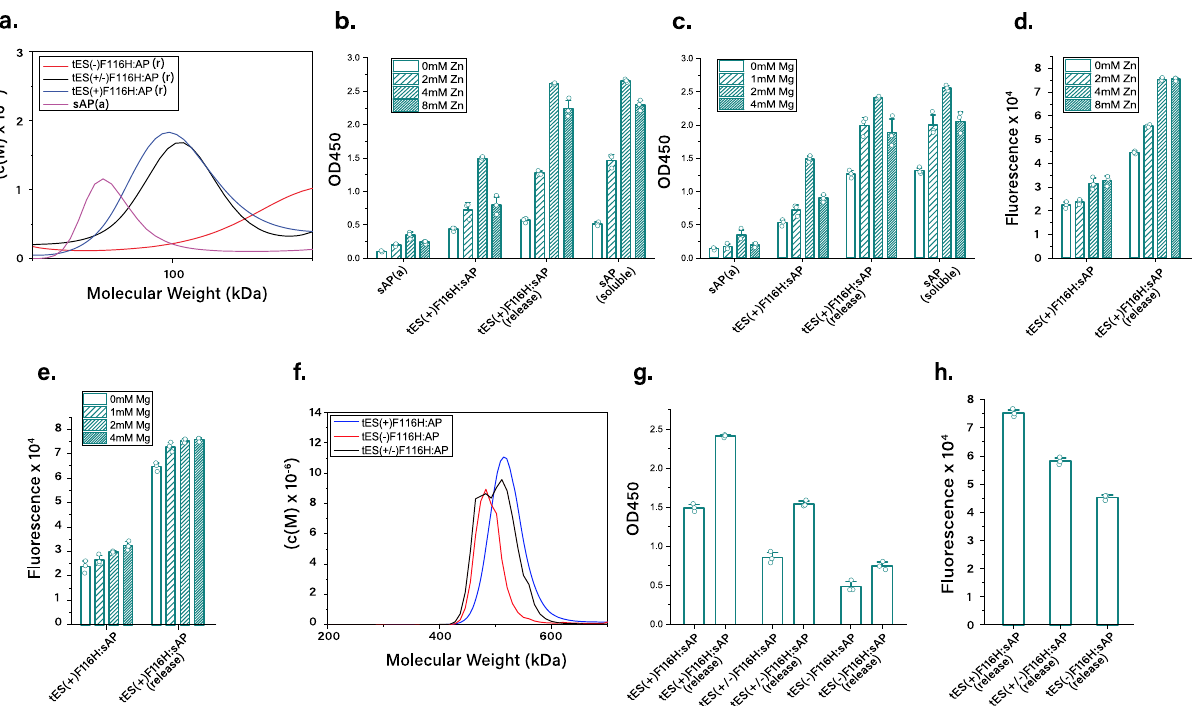
Fig. 4 Alkaline phosphatase folding with tES – F116H. a Release of sAP from tES – F116H charge variants results in a dimeric peak for tES – F116H( + ) and tES – F116H( + / – ), however, monomeric sAP was observed with sAP folded alone [sAP(a)] and aggregation was seen with the use of tES-F116H( – ). b , c Titration of Zn and Mg yields activity increases similar for caged versus released sAP and a solubly expressed sAP control. d, e Titration of Zn and Mg has differential effects on sAP intrinsic fl uorescence, a marker of folding. f AUC of tES-F116H( + ) loaded with sAP demonstrates a M.W. of 522 kDa, consistent with encapsulation of a single sAP monomer. g Activity of sAP is moderately increased after release from three charge variants of tES – F116H. h Intrinsic fl uorescence is optimal when sAP is folded with charge-matched tES – F116H( + ). ( b , c , d , e , g , h , data are presented as mean ± SEM., n = 3 independent experiments) (Source data are provided as a Source Data fi